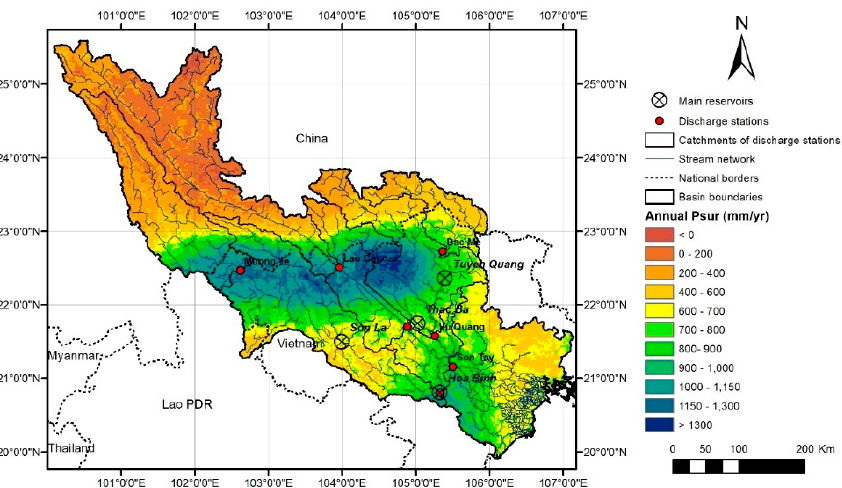
Figure 8. Map of annual average rainfall surplus in the Red River Basin based on January 2003–December 2012. Also indicated are the largest dams that provide opportunities for water storage. Hoa Binh and Thac Ba dam were operational during this entire period, Tuyen Quang and Son La dam were commissioned in 2008 and 2011, respectively.